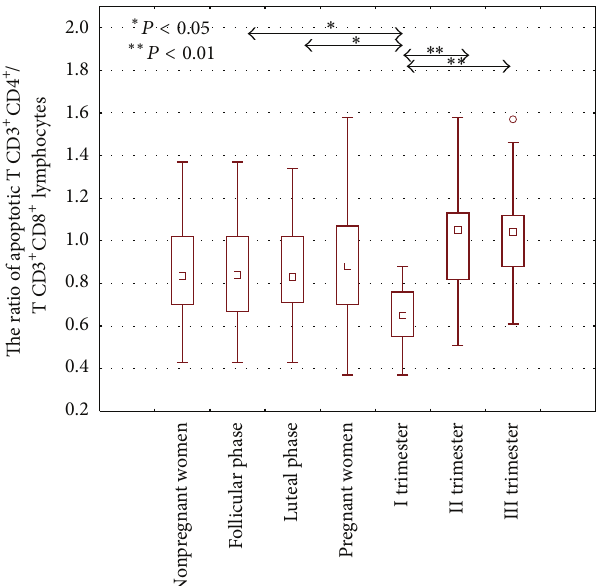
Figure 3: The ratio of T CD3 + CD4 + : T CD3 + CD8 + apoptotic lymphocytes in peripheral blood of women in the first ( 𝑛 = 20 ), second ( 𝑛 = 20 ), and third trimesters ( 𝑛 = 20 ) of normal pregnancy and in peripheral blood of healthy nonpregnant women in the phases of the menstrual cycle ( 𝑛 = 17